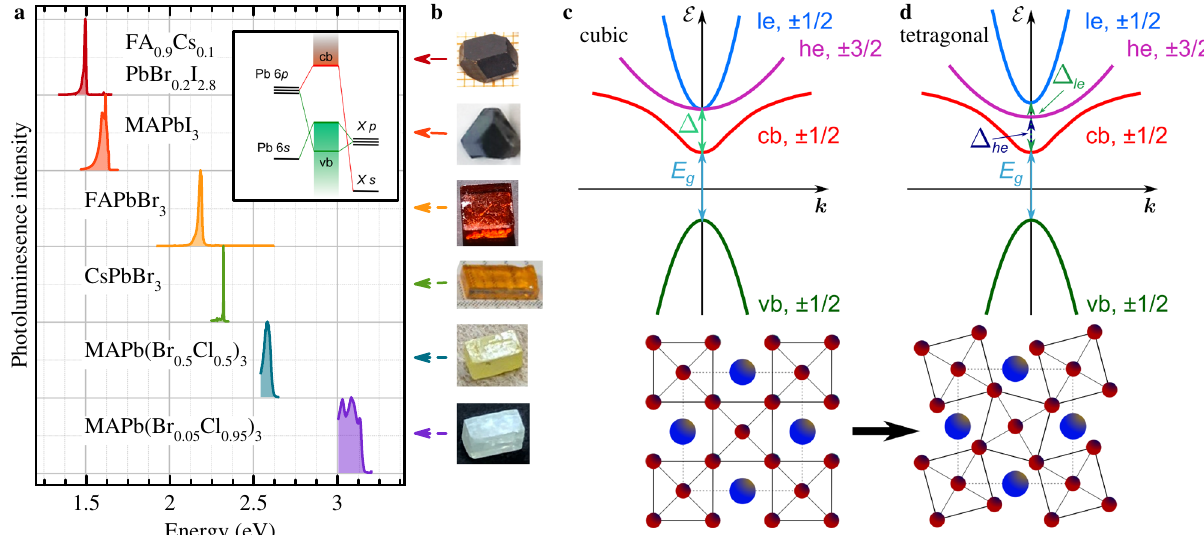
Fig. 1 Lead halide perovskite samples. a Photoluminescence spectra of the crystals under study. The spectra are normalized and vertically shifted for clarity. The PL is measured at T = 1.6 − 10 K. Inset shows a sketch of the contribution of atomic orbitals to the electronic bands around the band gap in lead halide perovskites. b Photographs of representatives of the samples under study. Arrows point to the respective PL spectrum. c , d Band structure around the direct gap for the cubic and tetragonal lattices. The states at the top of the valence band (vb, holes) and the bottom of the conduction band (cb, electrons) are spin-degenerate having spin ±1/2. The degenerate heavy (he, ±3/2) and light (le, ±1/2) electron bands are split-off signi fi cantly from the cb by the spin-orbit coupling Δ . A symmetry reduction from cubic to tetragonal lifts the he-le degeneracy, leading to individual split-off energies Δ he / le . In the bottom panels the corresponding lattice structure is sketched with the [Pb X 6 ] − 4 octahedra (dark red symbols show the halogen X anion) and A the inorganic/organic cation (dark blue). An octahedra twist provides the phase transition from cubic to tetragonal symmetry for the aristotype cubic structure (dashed line square) 34,37 .